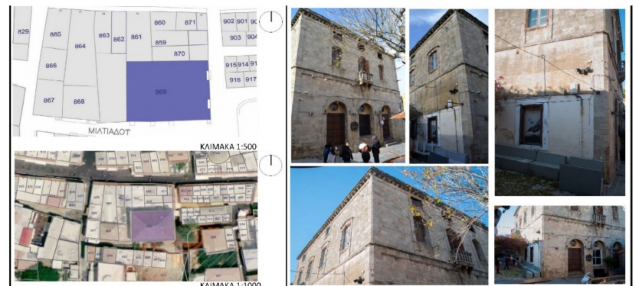
Figure 18. Sokratous 4T (parodos), (listed building—evaluation